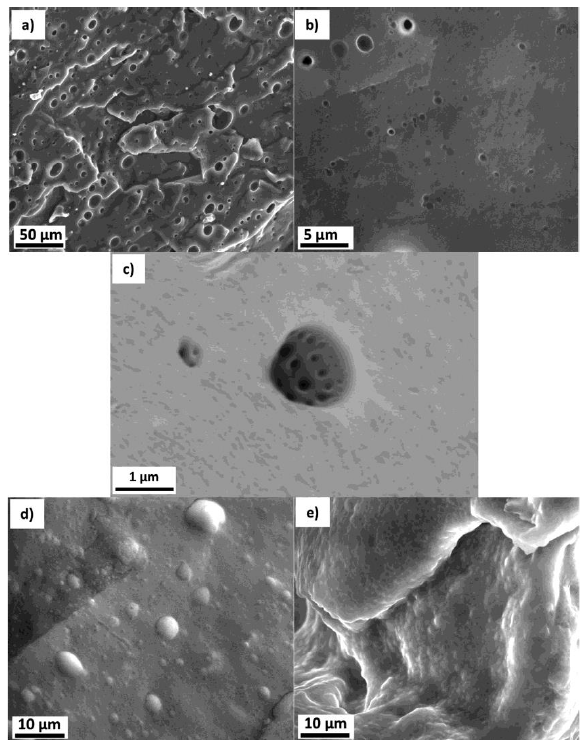
Figure 3. SEM images showing the morphology of porous silicones obtained without co-surfactant, from a dilute solution of T, emulsified with 10% water (( a , b ) — sample PE1), 20% water (( c ) — sample PE2-observed through atomic number contrast detector); and 10% water containing PEG (( d , e ) — sample PE3). In the next step, the formulation was changed, by addition of D (1%) in the aqueous phase as co-surfactant. This allowed us to obtain stable emulsions just by gentle manual mixing, while short time sonication in an ultrasound bath additionally increased the sta- bility and homogeneous aspect. The complex composition of the as-obtained emulsion can be visualized in Figure 4.